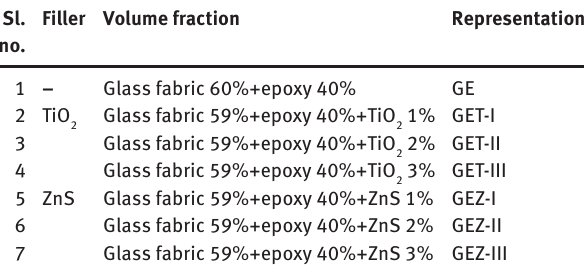
Table 1 Composite combinations.